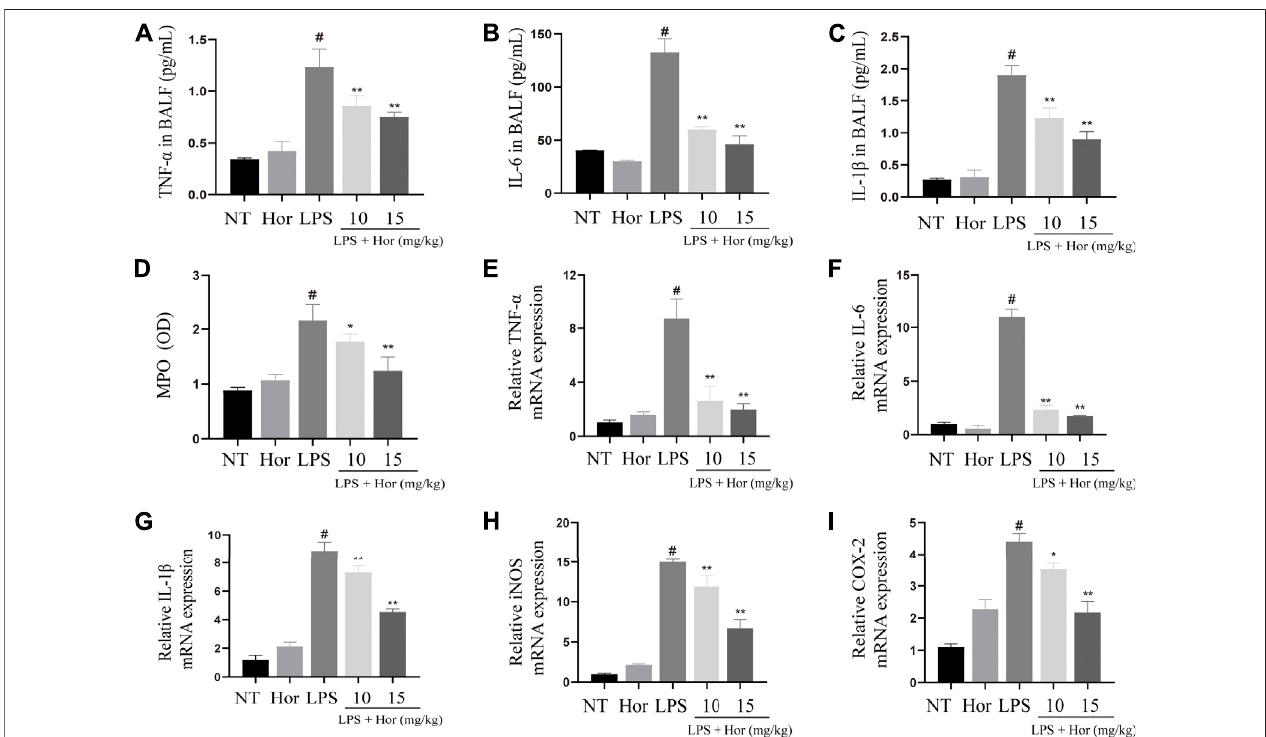
FIGURE 3 | Hordenine inhibits the secretion and activation of in fl ammatory cytokines in LPS-induced acute lung injury. BALF and lung tissues were collected at 24 hafter LPS infusion. (A – C) Levelsof IL-6, IL-1 β ,and TNF- α inthe BALF ofmice. (D) MPO activity inlung tissues. (E – I) mRNA expression ofin fl ammatory cytokines in the lung tissue of mice. Results are shown as means ± SD ( n (cid:1) 3). # p < 0.01 vs. no treatment (NT) group; p p < 0.05 vs. LPS group; pp p < 0.01 vs. LPS group. Hor: hordenine; LPS: lipopolysaccharide; BALF: bronchoalveolar lavage fl uid; IL-6: interleukin-6; IL-1 β : interleukin-1 β ; TNF- α : tumor necrosis factor- α ; MPO: